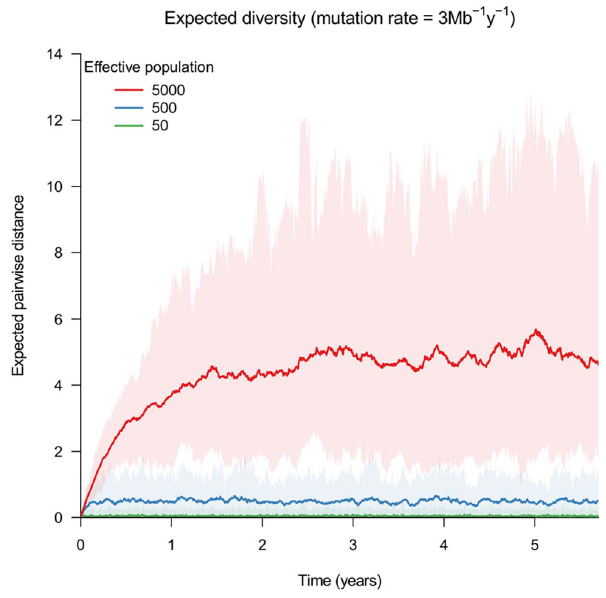
Figure 1. The development of diversity from an initial clonal population, using parameter estimates for S. aureus . The generation time was 30 minutes, the mutation rate was 3 | 10 { 6 per site per year, and we used an effective population size in the range of 50–5000.